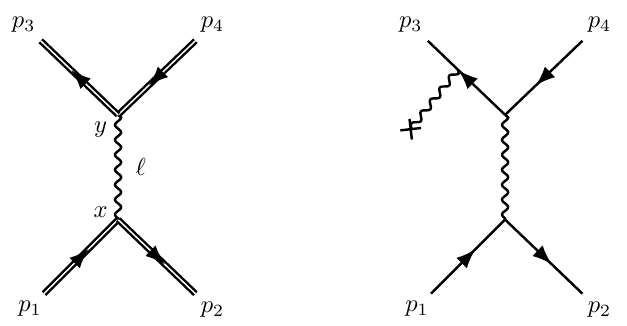
Figure 1. Left : the tree level e (cid:0) e + ! e (cid:0) e + amplitude (2.9) in a plane wave, where double lines represent the wavefunctions (2.6) which include all orders of interaction with the background. Right: one of the (four) lowest order, (cid:12)ve-point contributions to the same process, calculated perturbatively in the background, indicated by a photon line connected to